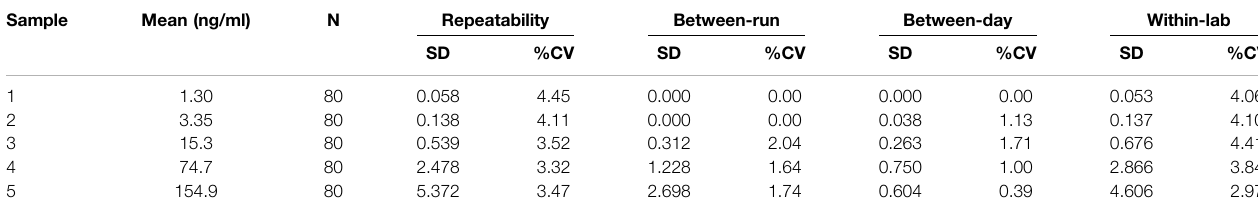
TABLE 2 | Statistical analysis for single-site precision. Sample